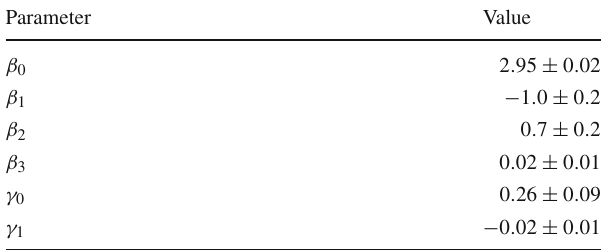
Table 2 Best-fit { β i , γ i } values defining the structure parameters of the LDF